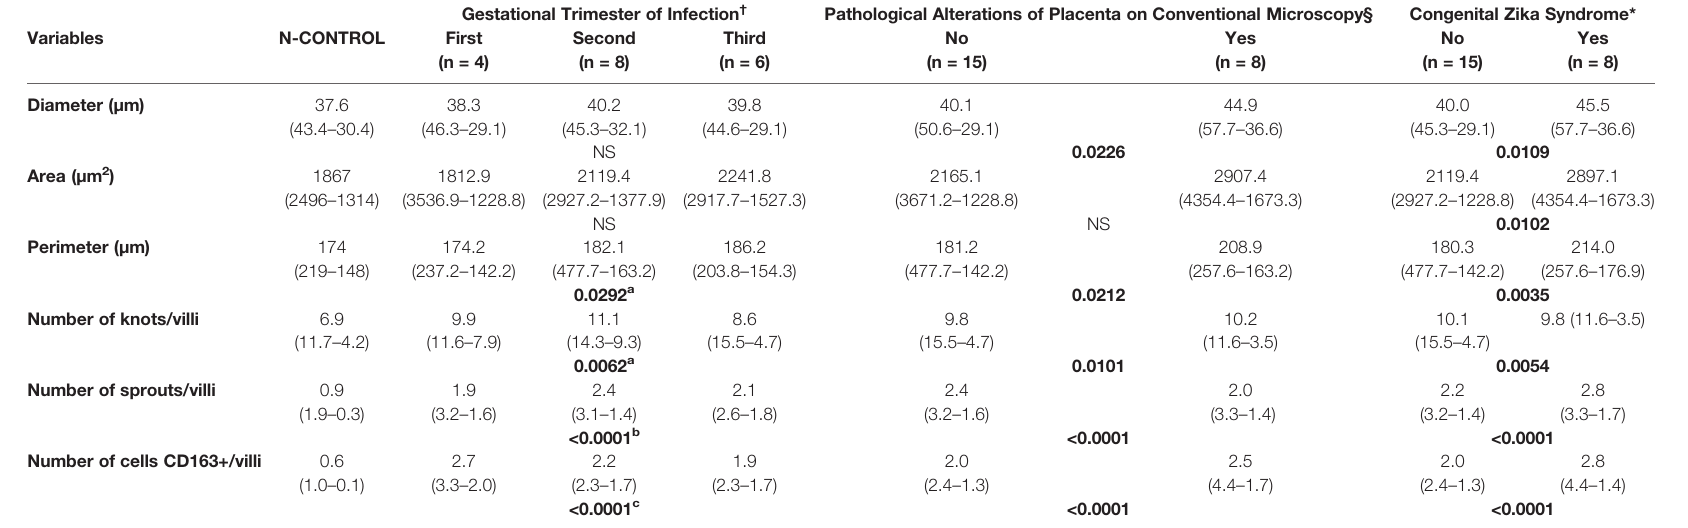
TABLE 1 | Median (max-min) and p -value of morphometric data in the gestational trimester of infection, presence of placenta pathological alterations, and